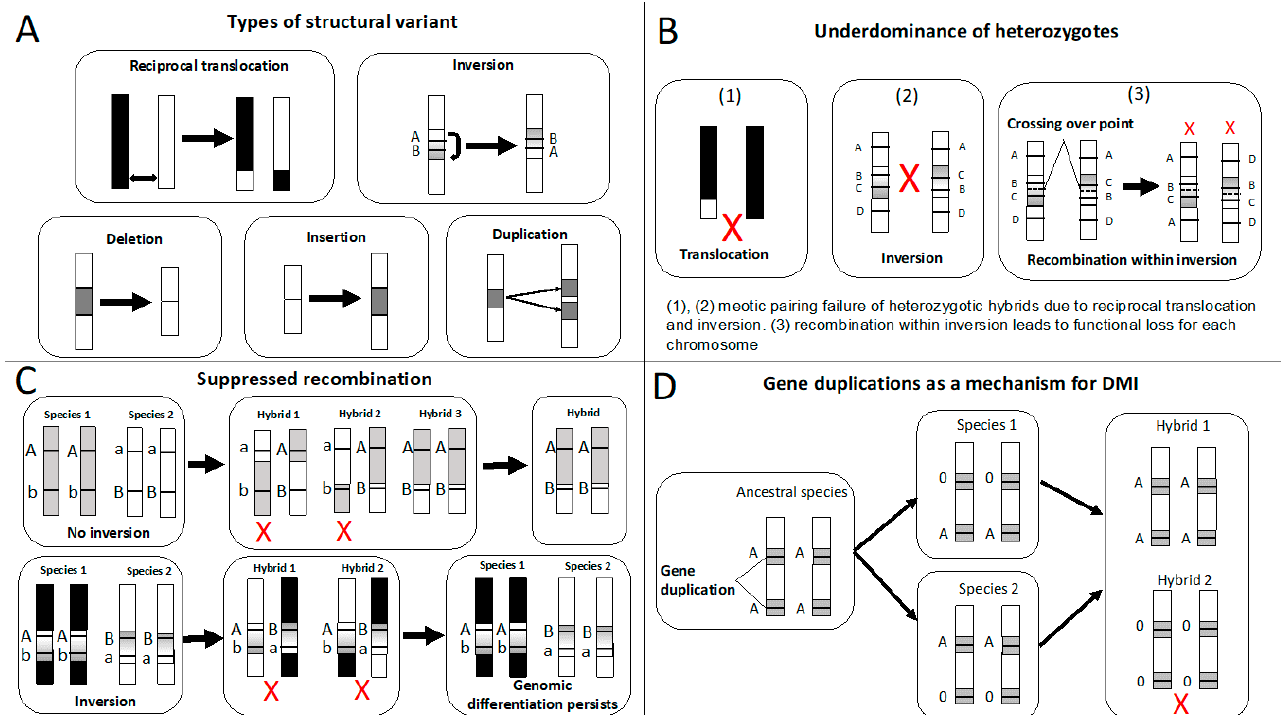
Figure 1. ( A ) Types of structural variants. ( B ) Underdominance of heterozygotes due to structural variants. Red Xs in (1) and (2) suggested meiotic pairing failure, while red Xs in (3) indicate reduced fitness of the individual. ( C ) Structural variants suppress recombination as a mechanism to prevent species from hybridizing. Allele a and b would cause hybrid inviability/sterility when present in the same genetic background. Without an inversion, recombination can break up the link between alleles at locus A and locus B and then selection can purge alleles a and b (see [14]). Red crosses indicate reduced fitness of the individual. ( D ) Gene duplications as a mechanism for DMI (Dobzhansky–Muller Incompatibilities). The 0 stands for loss of function at the locus. Red crosses indicate reduced fitness of the individual.